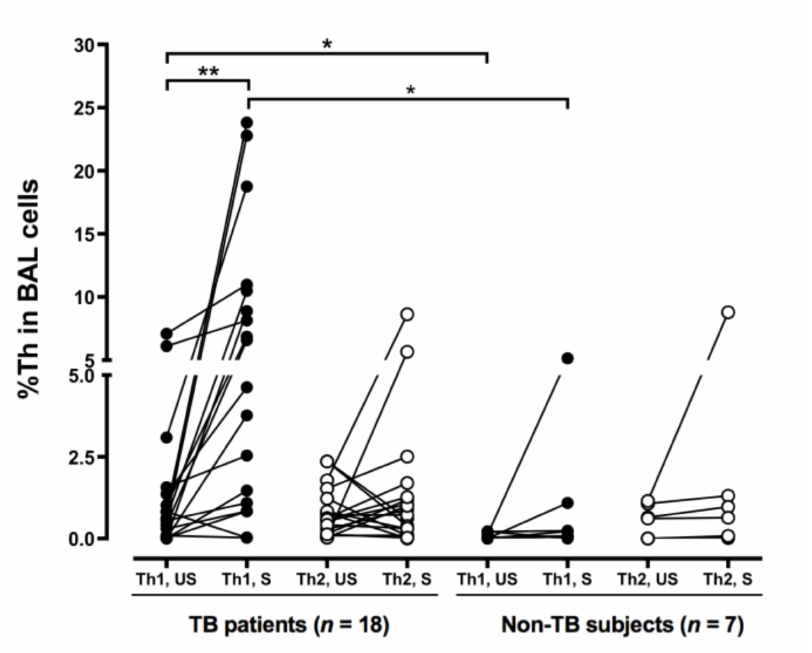
Figure 2. More BAL Th1 cells in the patients with tuberculosis. Cells from the TB patients and the non-TB subjects were collected by BAL and stimulated with phorbol myristate acetate and ionomycin. CD4 + /IFN- γ + Th1 and CD4 + /IL-4 + Th2 cells were identified by flow cytometry. The difference between cell profiles pre- and post-stimulation was determined by a paired t -test. The difference between cell profiles in participants with and without TB was determined by the Mann–Whitney test. * p < 0.05 and ** p < 0.01. BAL, bronchoalveolar lavage; Th1, type 1 CD4 + T helper; Th2, type 2 CD4 + T helper; %, percentage of CD4 + T helper cells; TB, tuberculosis; IL-4, interleukin-4; IFN- γ , interferon- γ ; US, unstimulated; S,